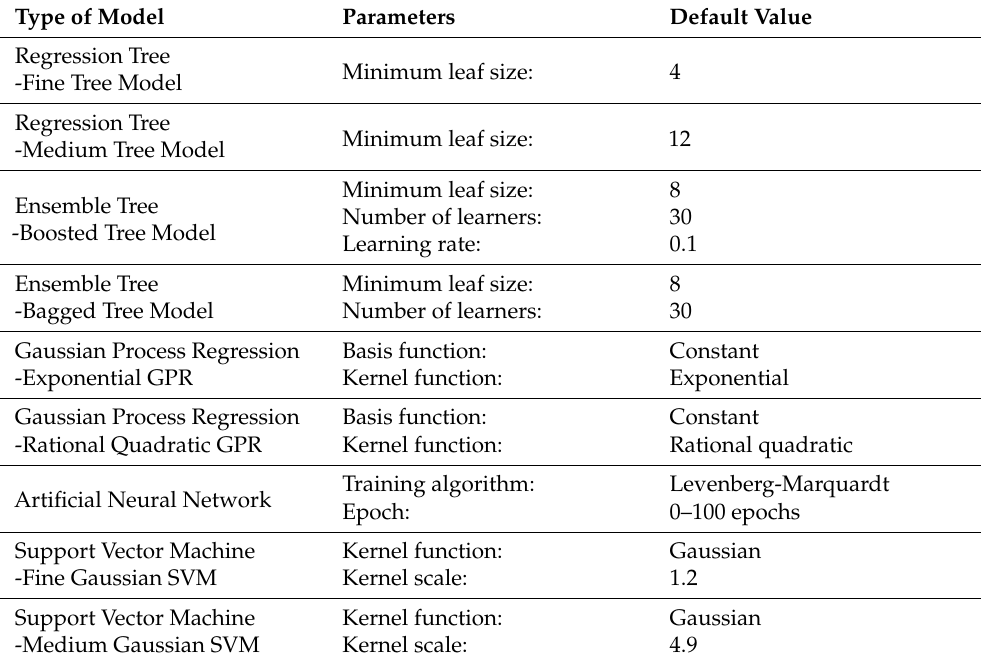
Figure 2. The architecture of the ANN model. Table 2. The criteria selected for the water quality parameters modeling for all models.